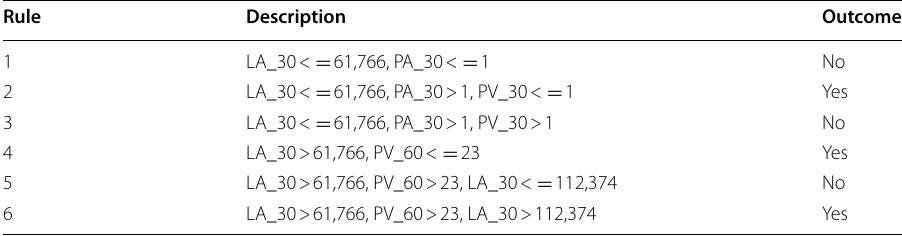
Table 8 Decision rules for combined tree (Tree 2)